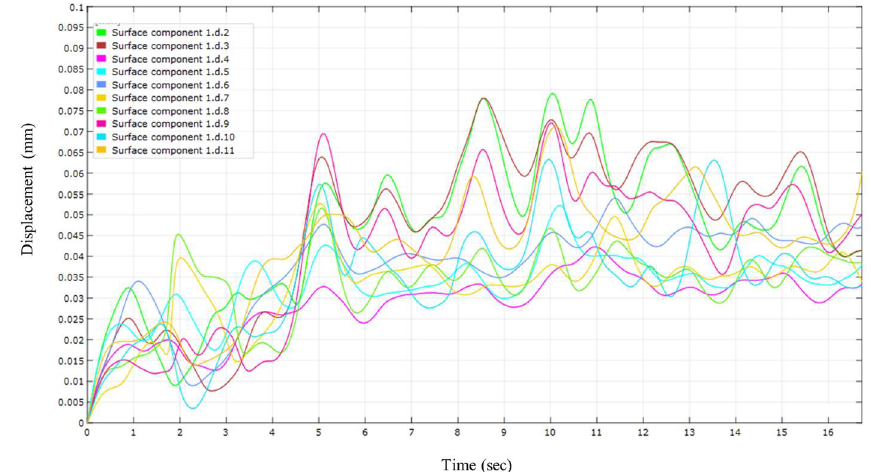
Figure 5. Blasting displacement curves of rock pillars ROI (DIC system).